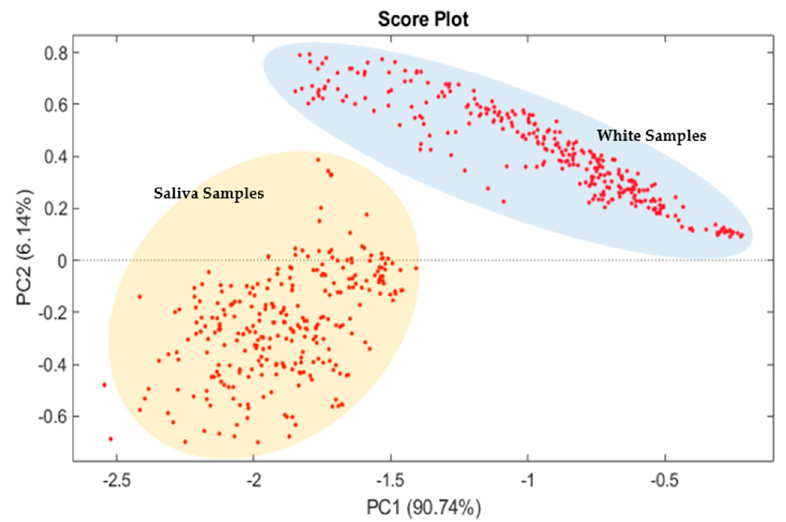
Figure 3. Principal component analysis (PCA) analysis of saliva and white samples are evaluated using a PCA method. Here the plot score of the first two principal component is reported. It contains almost the 97% of the explained variance. Here, two clusters can be distinguished: the blue one is composed of white samples while the orange cluster is made of saliva samples.